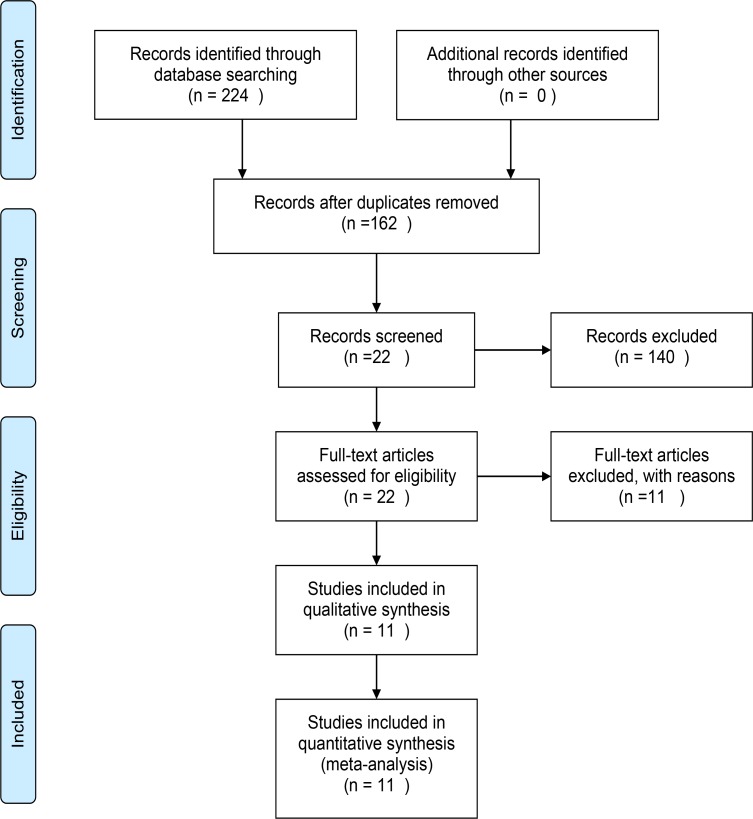
Flow chart of study selection in the meta-analysis.